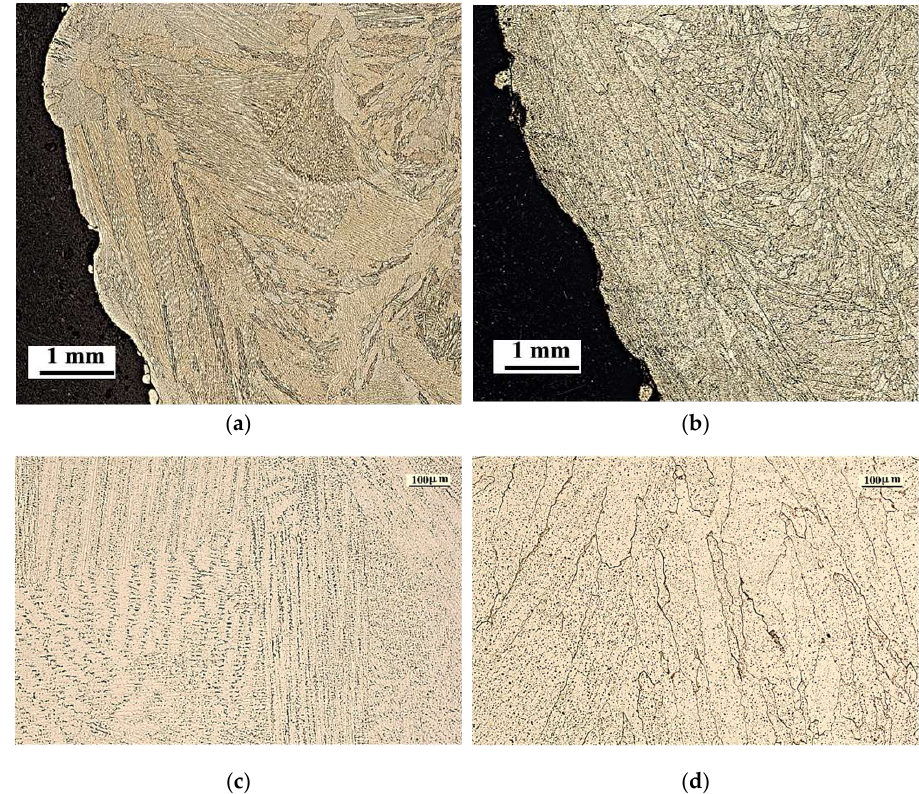
Figure 5. Cross-sections structure on the upper zone: ( a , c ) as-deposited; ( b , d ) solubilization and aging (STA).